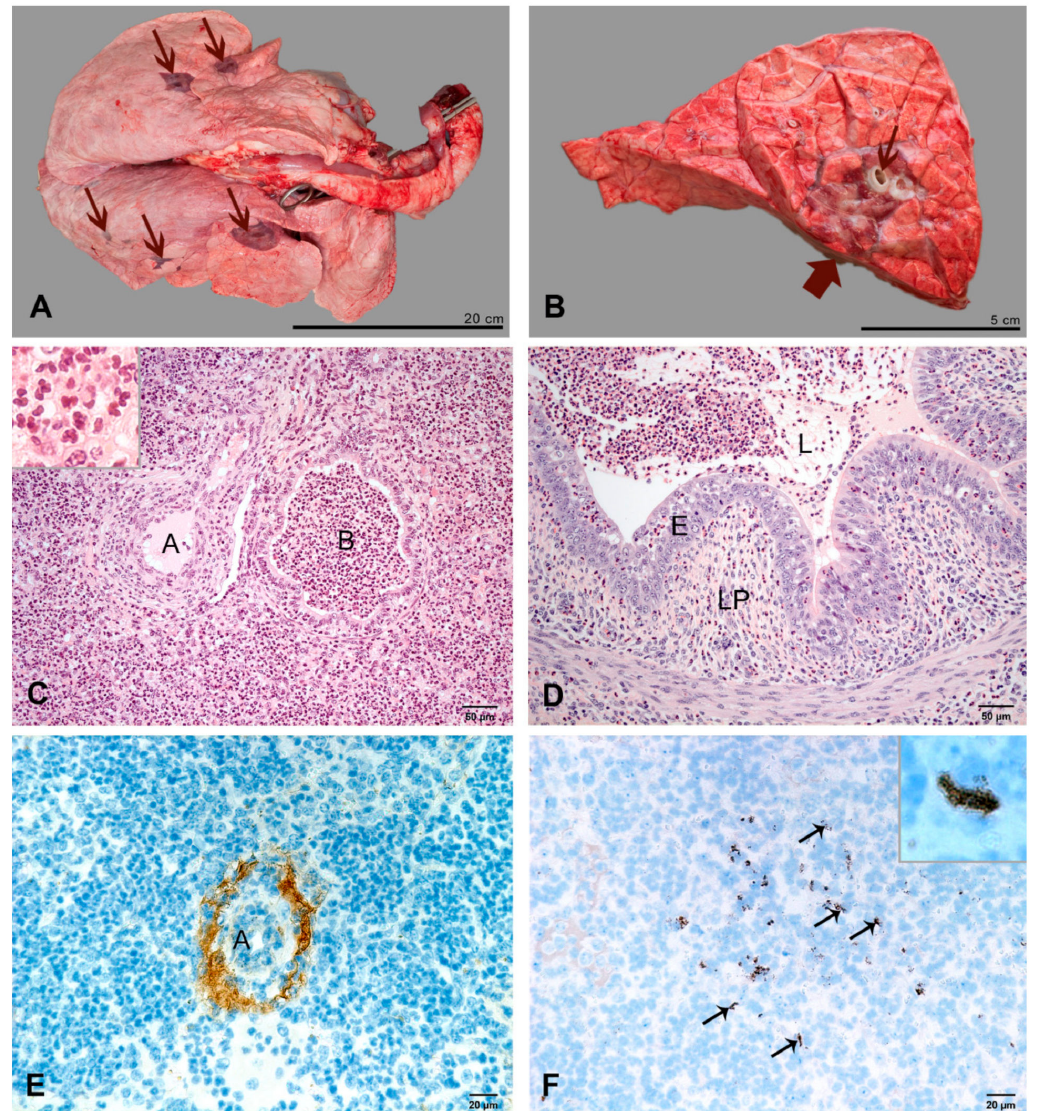
Figure 2. Pulmonary lesions at 2 dpi. ( A ) Macroscopic appearance and distribution of pulmonary lesions (dark red, arrows). ( B ) Section through the left basal lobe. A circumscribed, dark red and sunken lesion (thick arrow) is centered around a bronchus (thin arrow). ( C ) A bronchiolus (B) and the surrounding alveoli are distended by neutrophils. The wall of the arteriole (A) is infiltrated with neutrophils. Inset: higher magnification of neutrophils in an alveolus. HE-stain. ( D ) Numerous neutrophils in the lamina propria (LP), epithelium (E) and lumen (L) of a bronchus. HE-stain. ( E ). Fibrin precipitates (brown) surrounding a small arteriole (A). IHC, factor VIII. ( F ) Few chlamydial inclusions in type 1 alveolar epithelial cells (arrows, examples). Inset: higher magnification of a chlamydial inclusion. IHC,